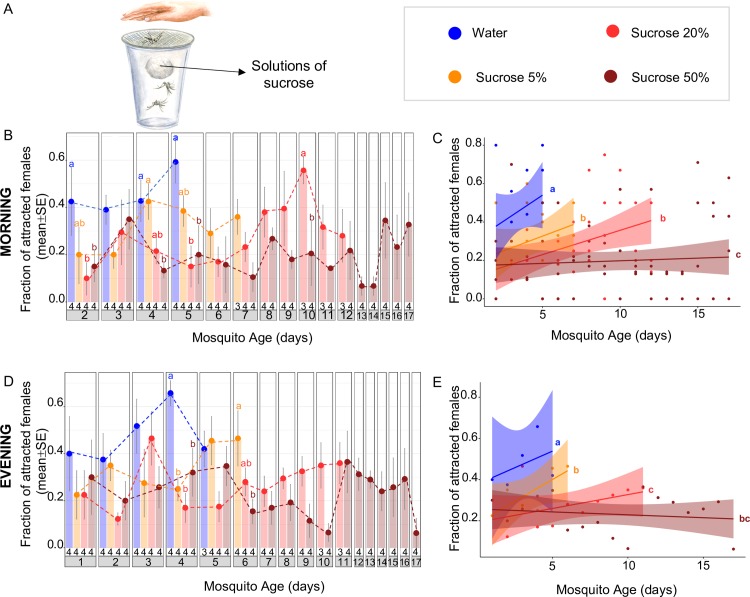
Sucrose feeding reduces host-seeking behaviour in Ae. albopictus.(A) The experimental procedure of the host-proximity assays used to measure female attraction to human hosts. Newly emerged females (<24 h of age) were placed into transparent plastic cups (10–12 females per cup), and food was provided on a cotton ball soaked in sugar solutions (5%, 20%, or 50% sucrose) or water. Attraction was measured daily by placing a human hand in close proximity over the cup and scoring the number of females actively probing at the hand through the net after 1 min of exposure. (B–E) Host-seeking behaviour was significantly reduced in females with access to sucrose compared to starved females, both in the morning (B, C) and in the late afternoon (D, E). The sugar-mediated reduction of host-seeking behaviour was dependent on sugar concentration (B–E). Results are expressed as mean ± SE, and the exact sample sizes (i.e., number of replicate cups) per day and feeding condition are given at the bottom of the bar plots (B, D). Letters indicate statistical differences (all p < 0.05 after FDR correction) between feeding conditions (i) for each day, based on pairwise Mantel–Haenszel χ2 tests (B, D), and (ii) over the entire time course by comparing the regression lines of the different experimental groups using ANCOVA (C, E). The underlying data can be found within S2 Data. ANCOVA, Analysis of Covariance; FDR, False Discovery Rate.